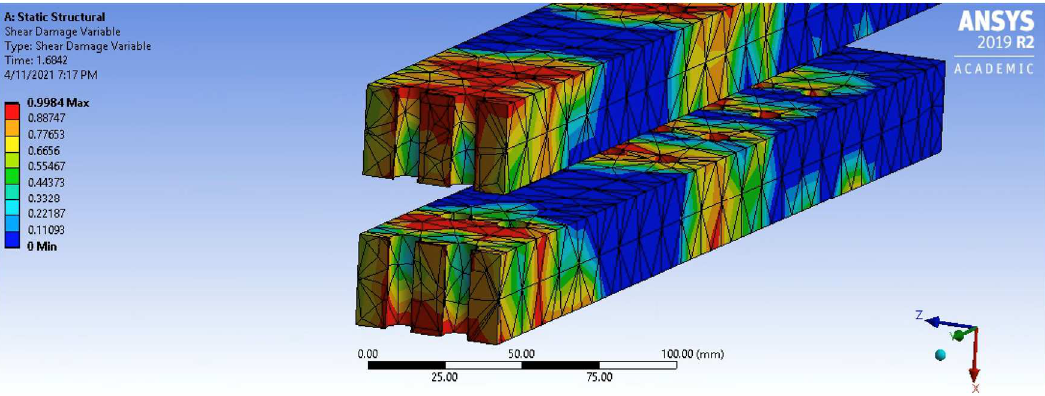
Figure 18. Shear Damage Status at the Beginning of Phase 3.